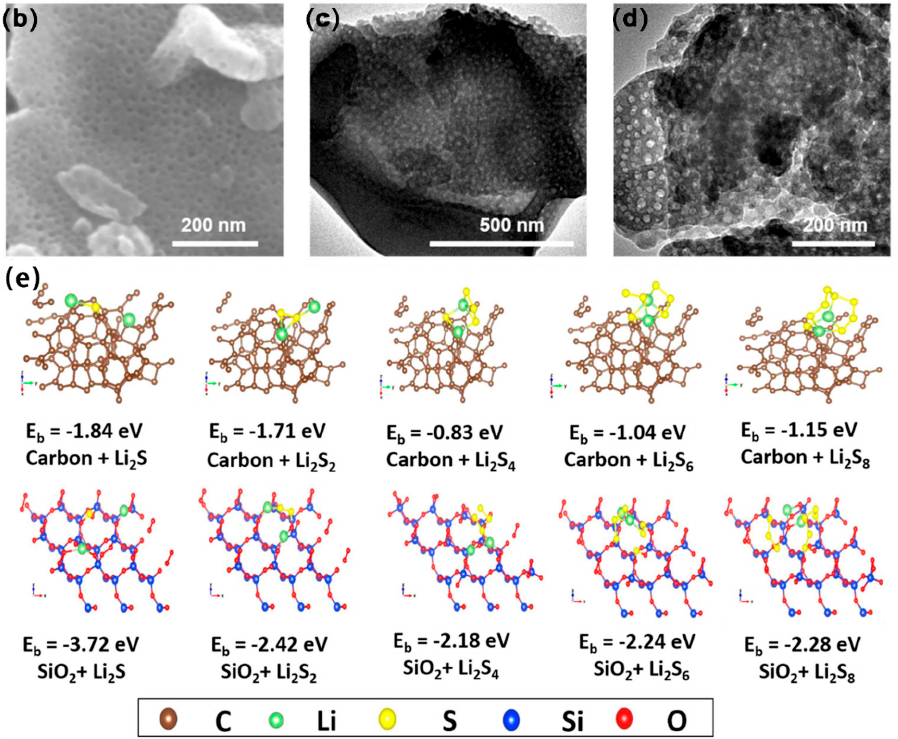
Figure 13. ( a ) Schematic diagram of the preparation of S/rGO@mC-MnO-800 composite electrode. ( b ) SEM and TEM ( c , d ) images of S/rGO@mC-MnO-800 composites [103]. ( e ) Theoretical DFT simulation of the interactions between SMC/SiO 2 and LiPSs [102].